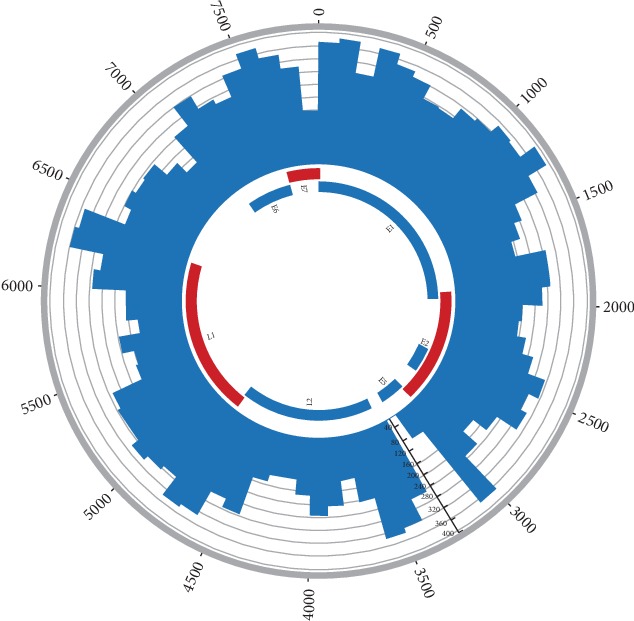
Distribution of breakpoints in the HPV16 genomes in 35 samples. Note: histograms (black) of the frequency of breakpoints in the samples were constructed for 100 bp intervals. Histogram axis units represent the number of breakpoints, and outer DNA numbering is given in bases. HPV genes with different functions are colored.